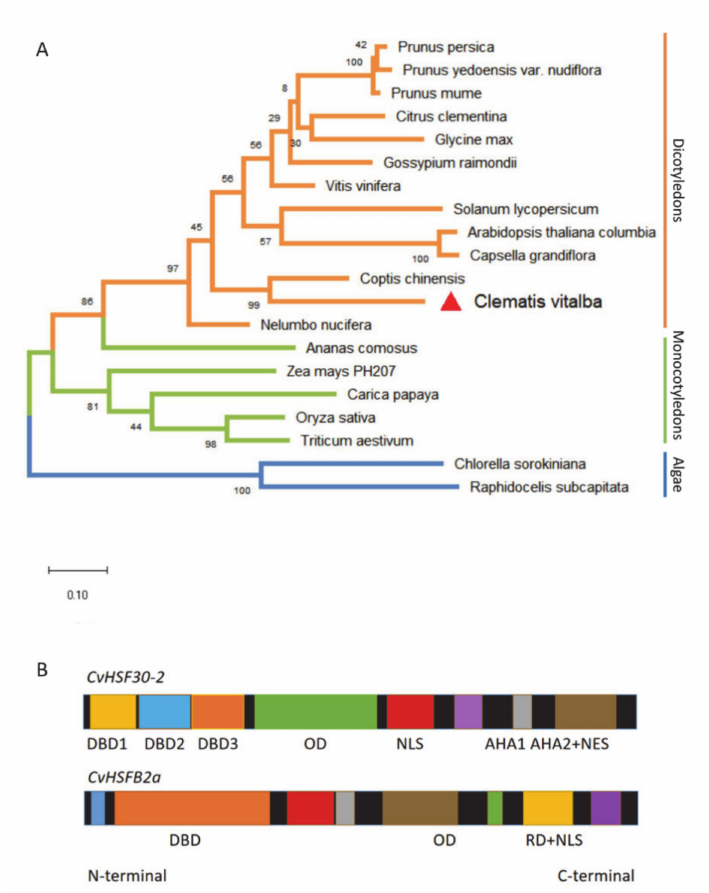
Figure 3. Phylogenetic and motifs analysis of heat shock transcription factors (HSFs). ( A ) Phy- logenetic analysis of HSF30-2 in different species. The accession numbers of HSFs are shown top to bottom as follows: XP_008220492.1, Prupe.1G410400.7, PQM38437.1, NP_001290015.1, Gorai.013G220400.5, Ciclev10008618m, Glyma.14G096800.3, Solyc08g062960.2.1,